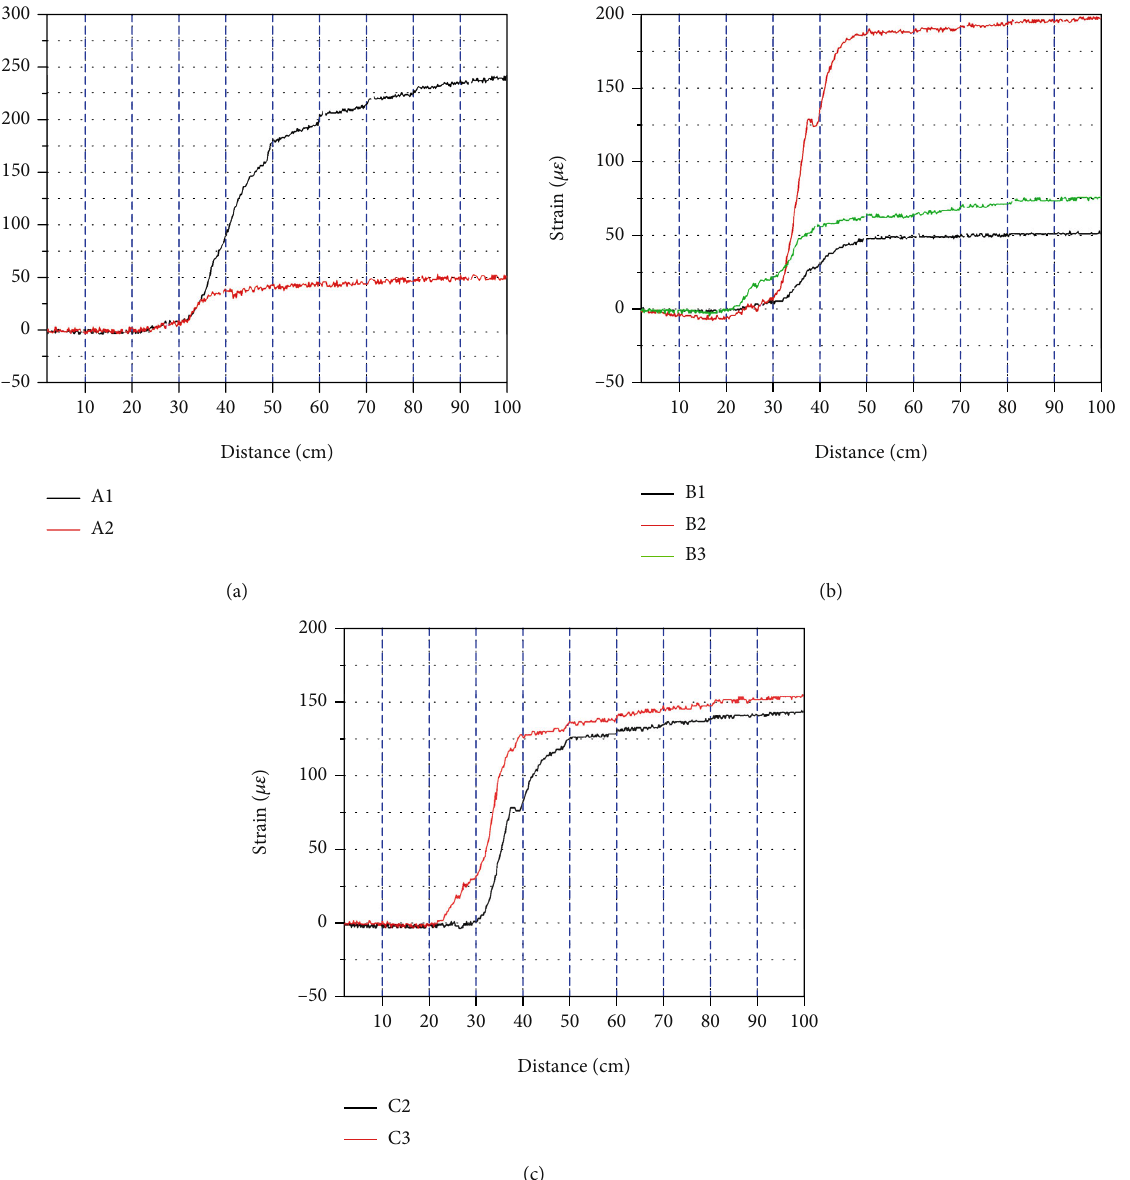
Figure 12: Strain monitoring during excavation: (a) monitored data of grating string A; (b) monitored data of grating string B; (c) monitored data of grating string